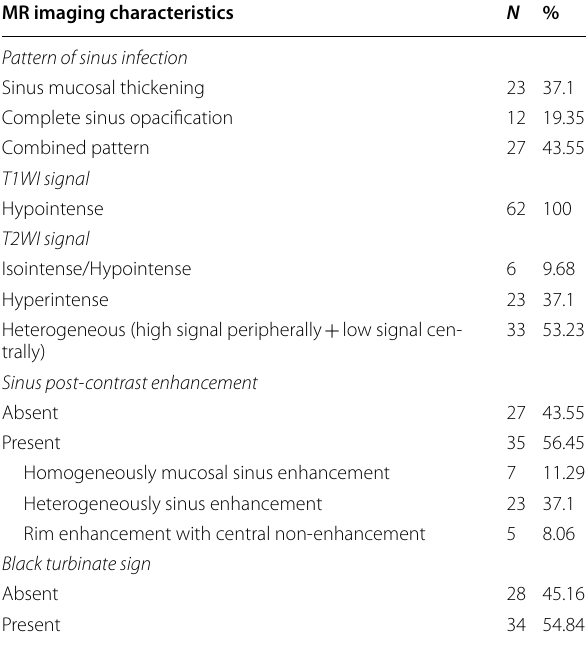
Table 5 MR imaging pattern for sinus